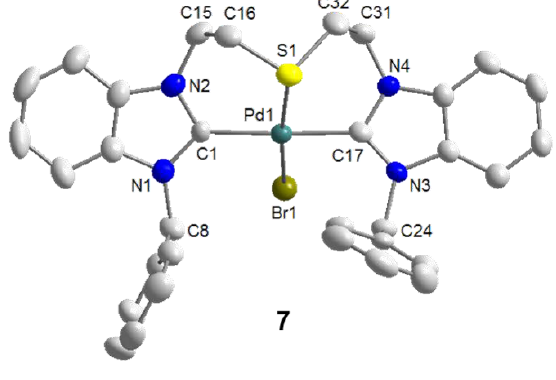
Figure 8. Molecular structure of 7 . The non-coordinating counter-anion NO 3- has been omitted